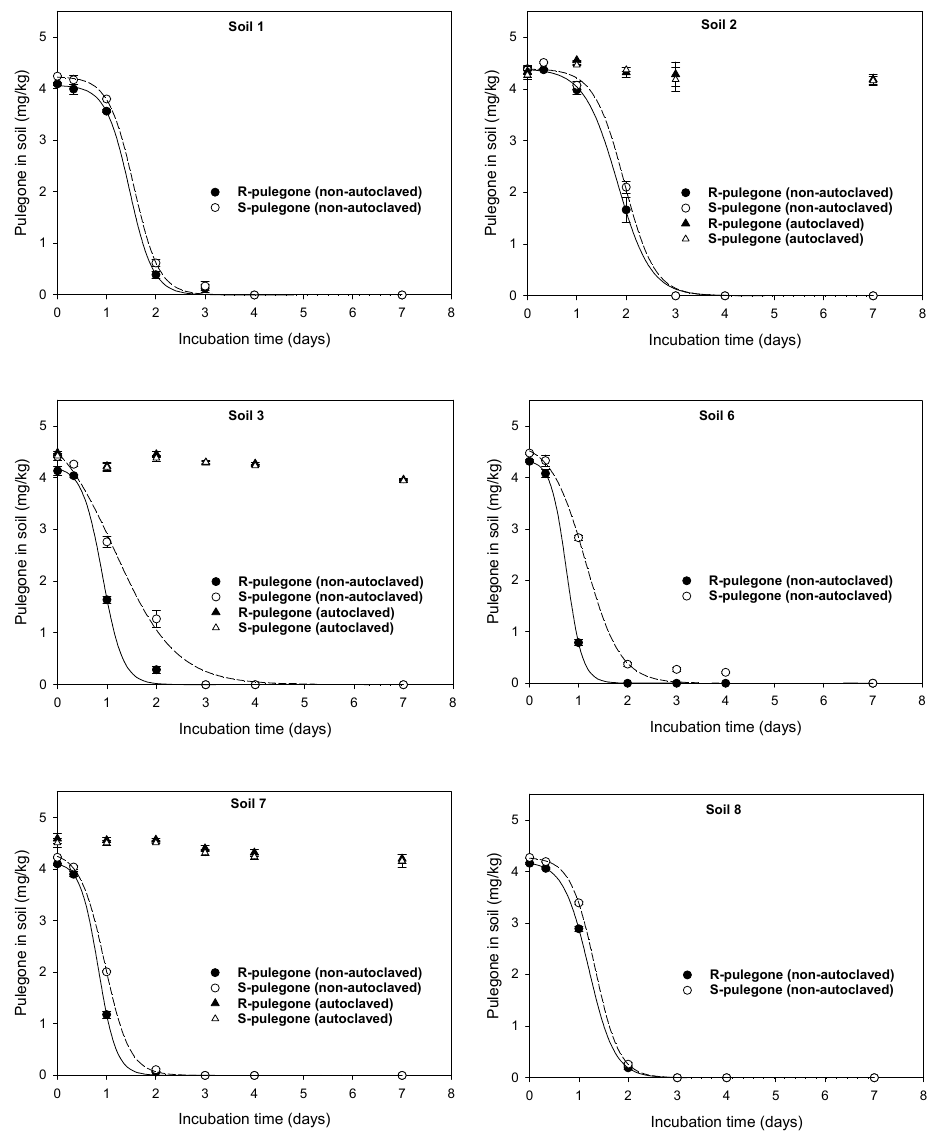
Figure 3. Dissipation patterns of R- and S-pulegone in non-autoclaved and autoclaved soils. Symbols indicate experimental data points whereas lines correspond to the fits of a sigmoidal three-parameter equation to the experimental data. Error bars denote standard errors of triplicate measurements.